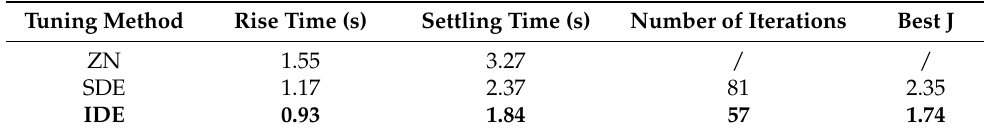
Table 2. Comparisons of controller tuning methods with step reference.